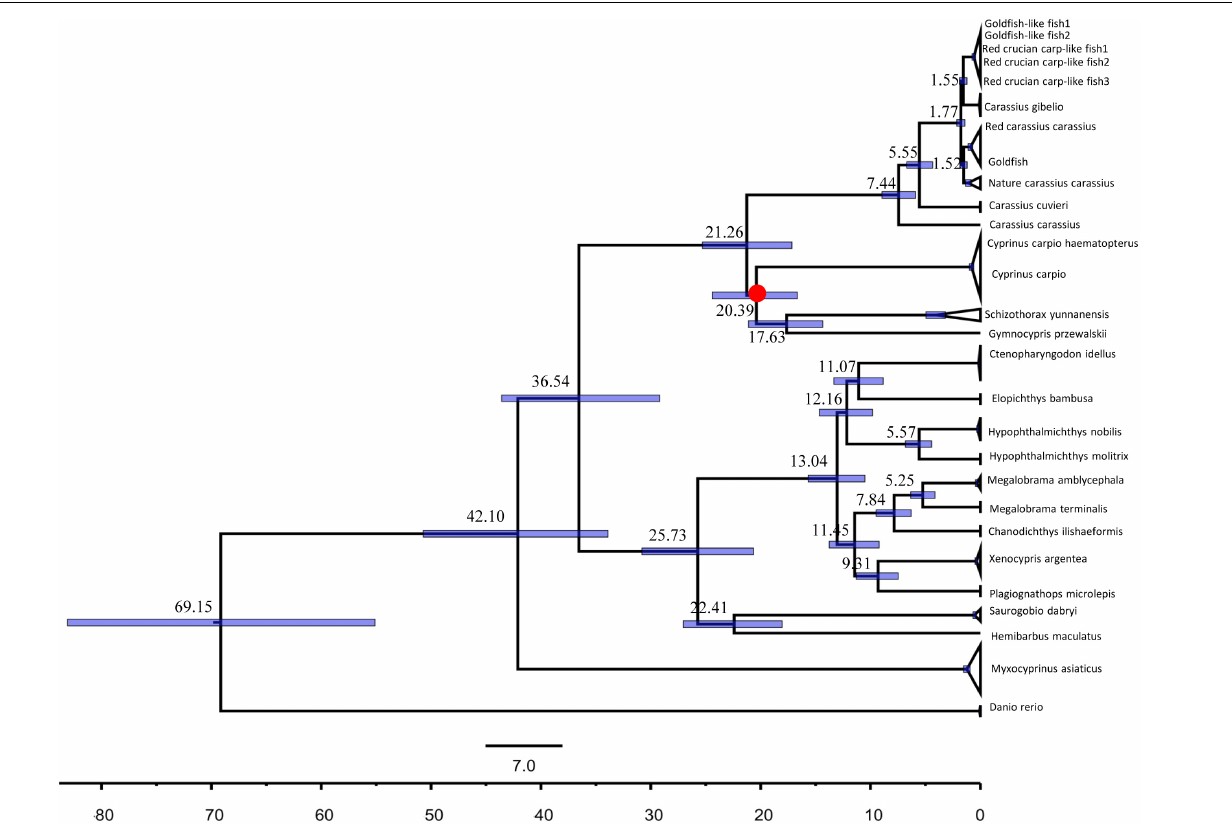
FIGURE 5 | Dated Bayesian phylogeny of KOC, BSB, RCC-L, GF-L, RCC, and GF, as well as other fish in the Cyprinidae (e.g., Carassius carassius , Carassius gibelio , Carassius auratus , and Carassius cuvieri ), based on the concatenated mitochondrial genes including 13 protein coding genes, two rRNA, and one Doop. Schizothoracine fish calibration points were used to estimate the time of divergence between the GF-L lineage and